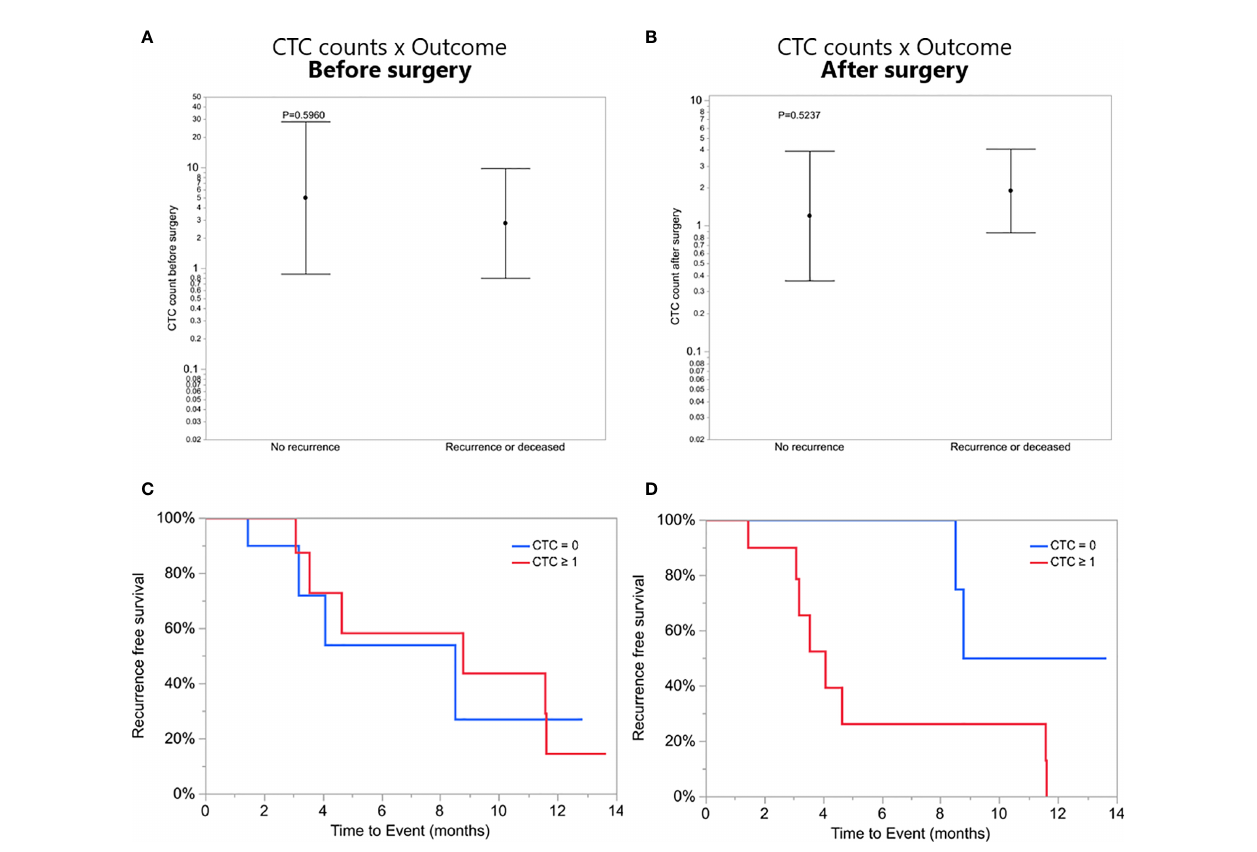
FIGURE 4 | (A, B) CTC counts of patients with poor outcomes (recurrence or death) versus patients with good outcomes (stable disease and no recurrence), before and after surgery, respectively. (C, D) Recurrence-free survival. Kaplan-Meier curves showing recurrence-free mean survival time of CTC = 0 group and CTC ≥ 1 group before and after surgery,